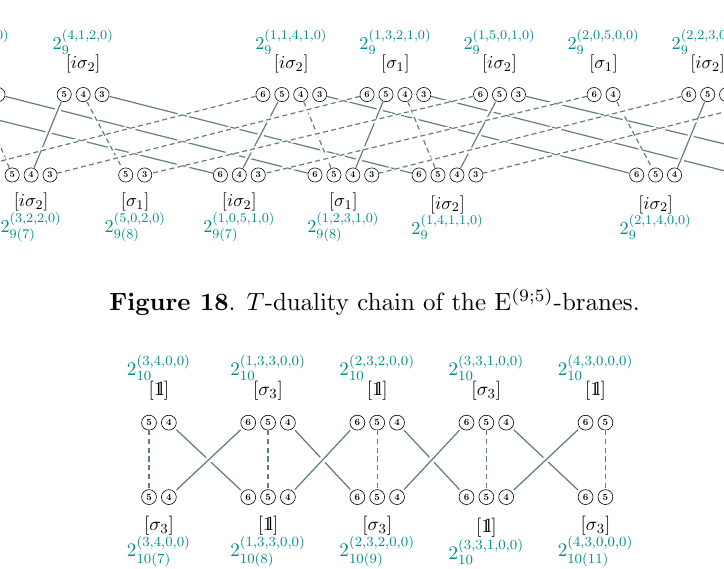
Figure 17 . T -duality chain of the E (8;3) -branes.